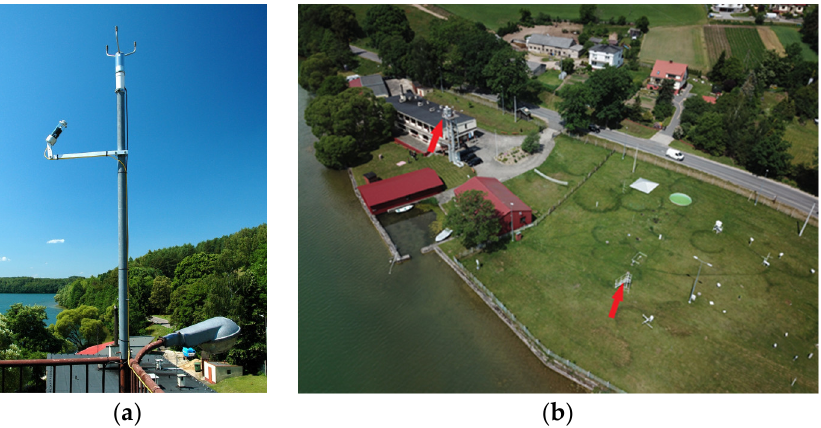
Figure 3. CSD3 sensor ( a ) and location of both measurement instruments ( b ) at the Borucino Limno- logical